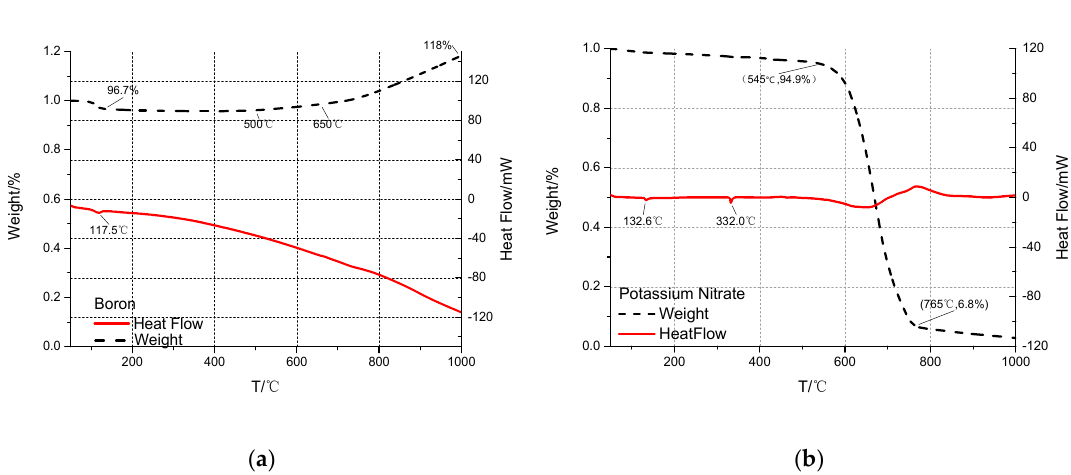
Figure 2. ( a ) Thermogravimetric-Di ff erential Scanning Calorimetry (TG-DSC) curve of boron powder; ( b ) TG-DSC curve of KNO 3 (in nitrogen atmosphere).